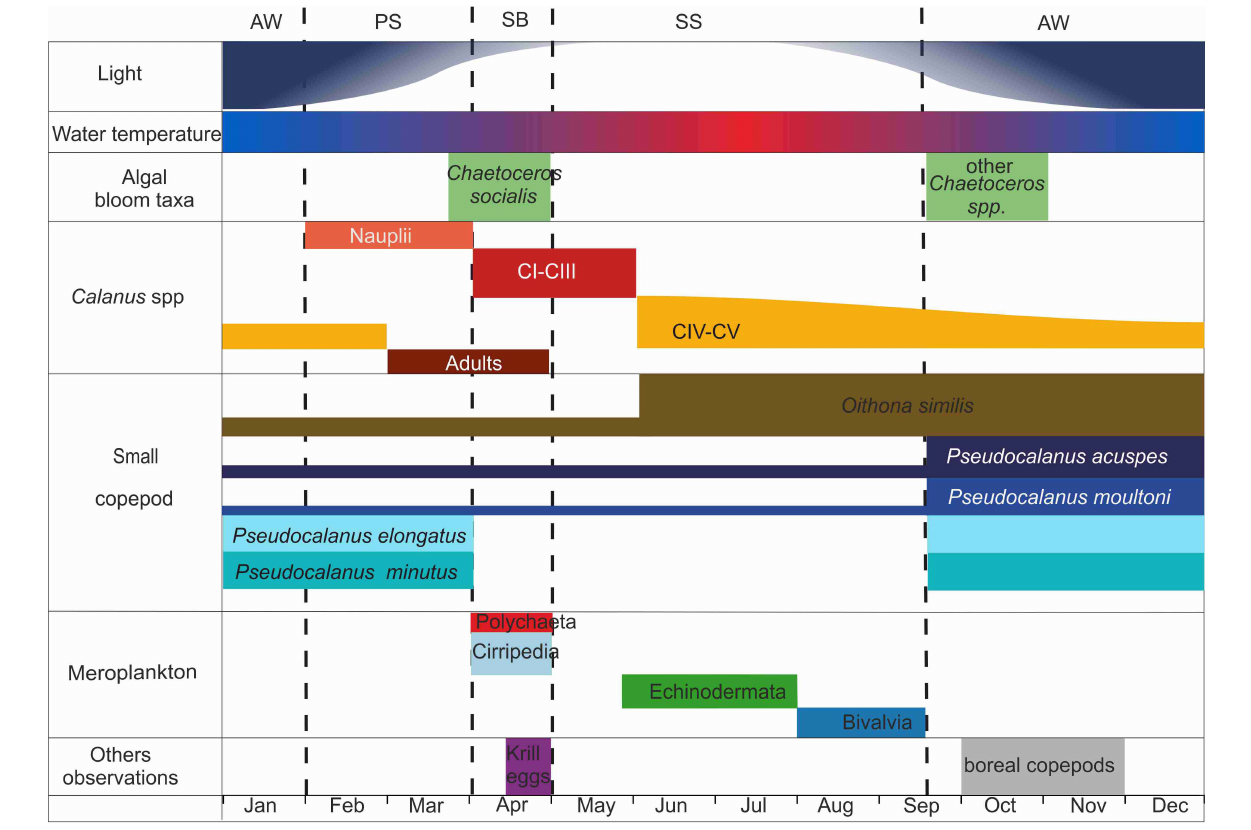
Frontiers in Marine Science |